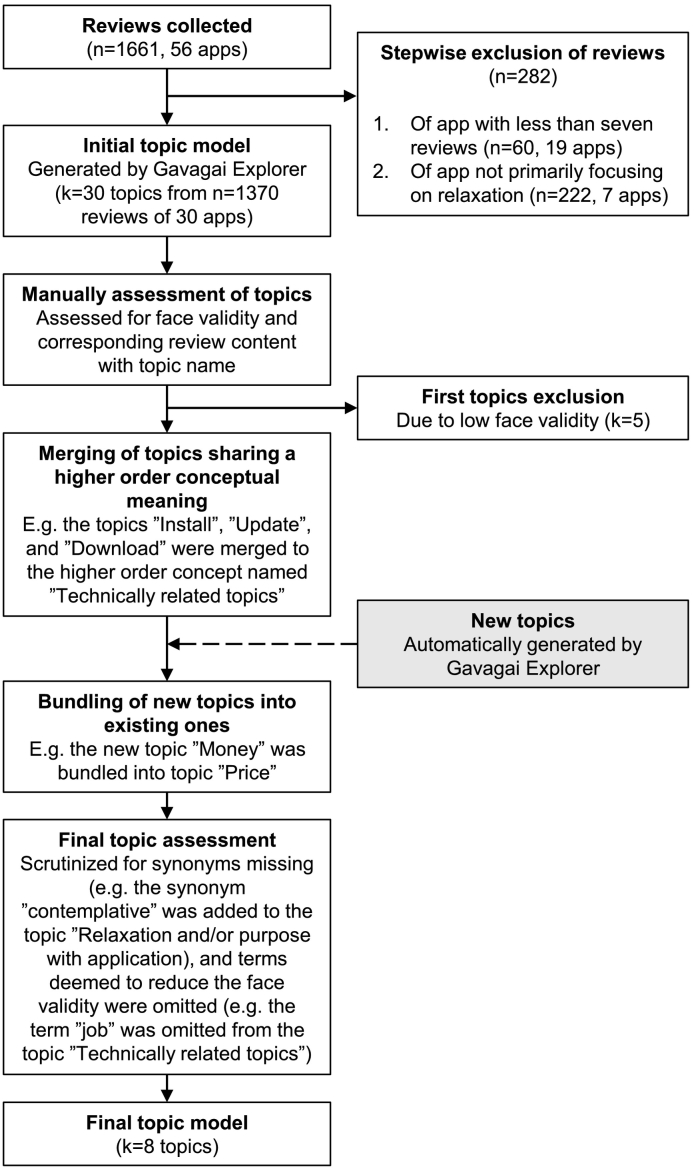
Analysis flowchart.